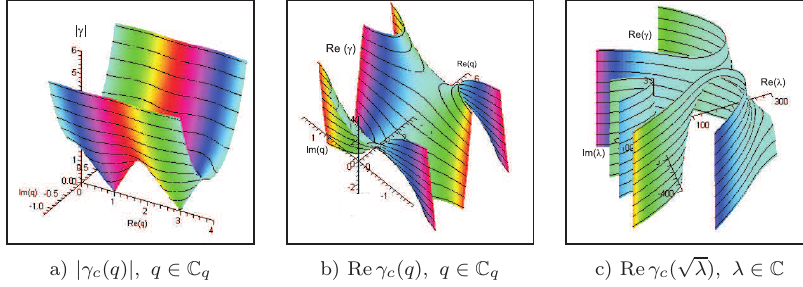
Figure 3. The complex characteristic function γ c ( πq ) for ξ = 1 / 2 .